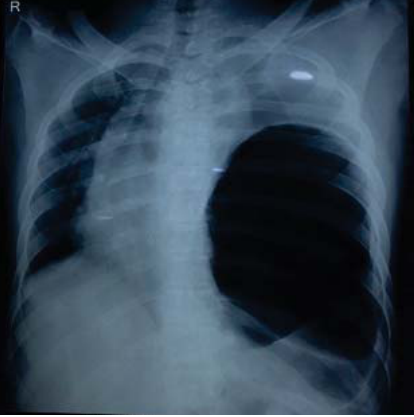
Figure 1. Chest X-ray at the time of